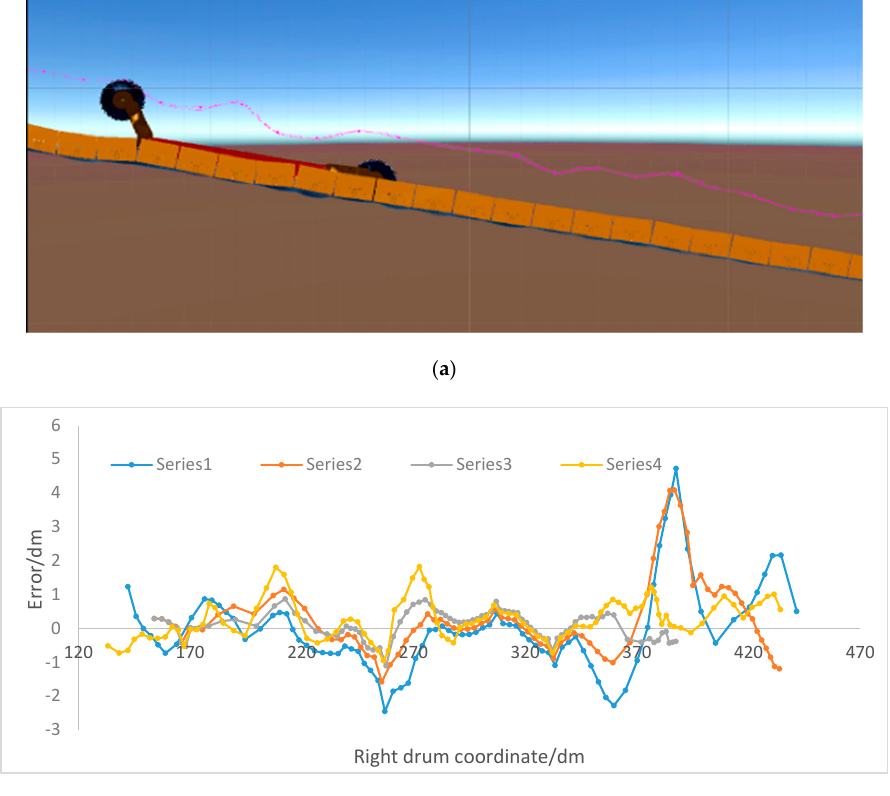
Figure 12. Simulation results: ( a ) three-dimensional graph of cutting curve ( b ) error of the actual cutting points and the preset